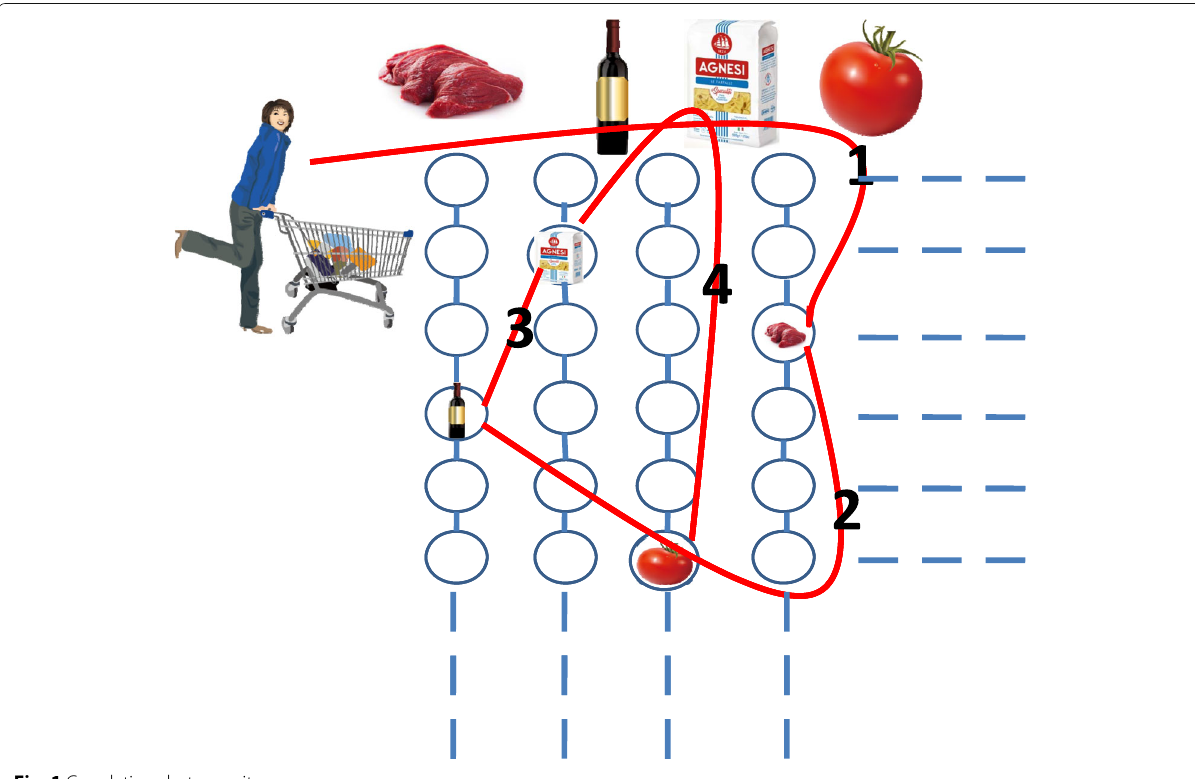
Fig. 1 Correlations between